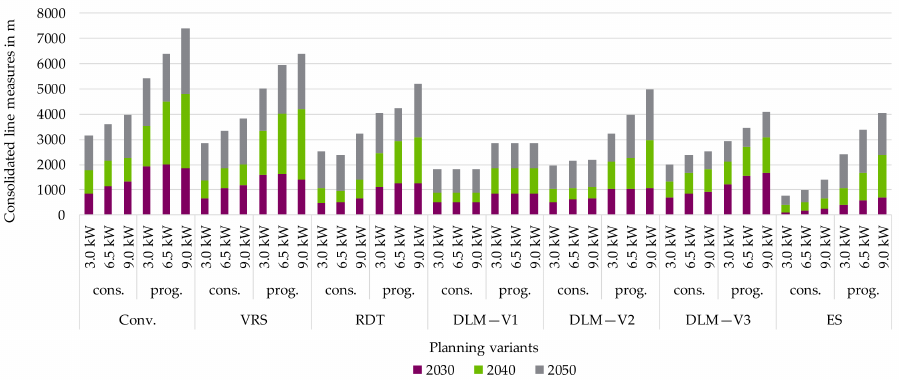
Figure 17. Necessary line measures consolidated across all conventional and innovative planning variants from the perspective of the feeders for 18 low-voltage grids.